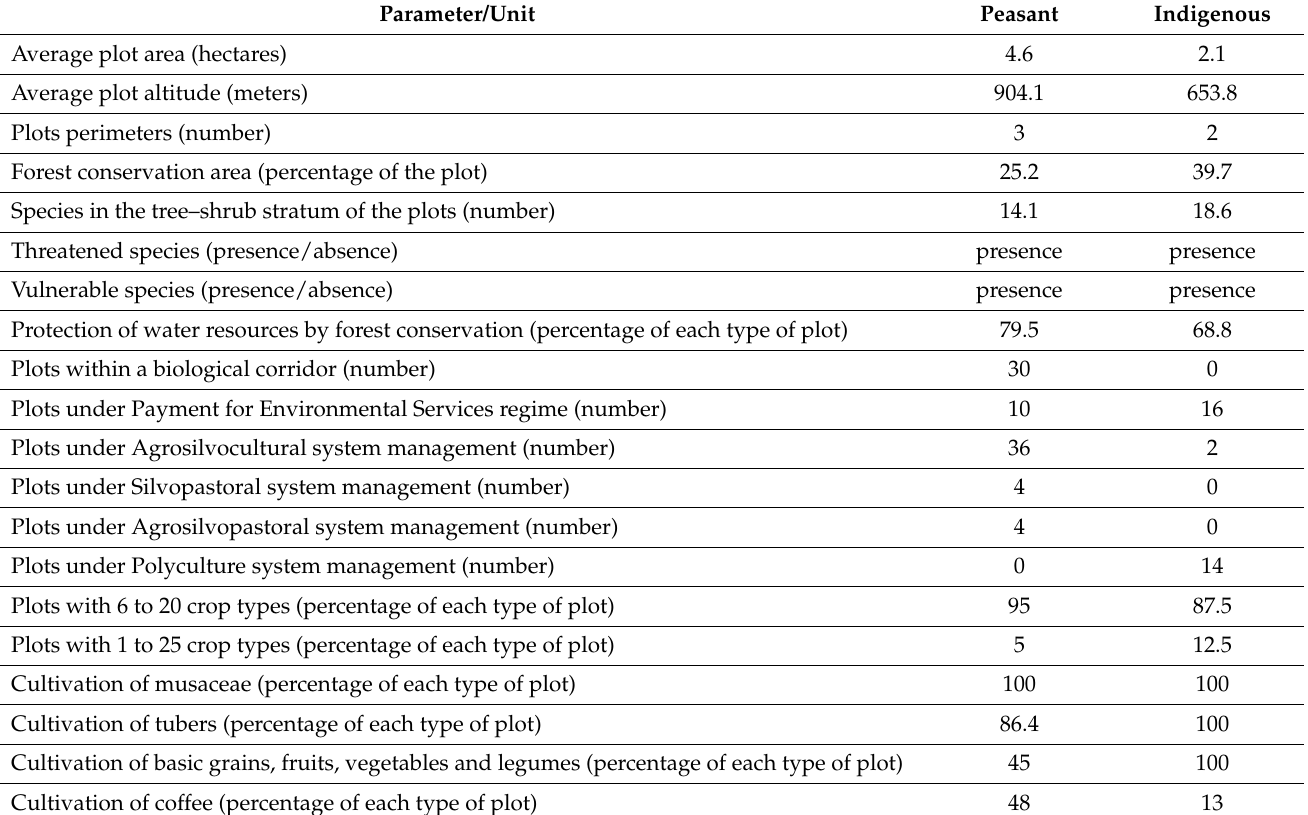
Table 5. Summary table of